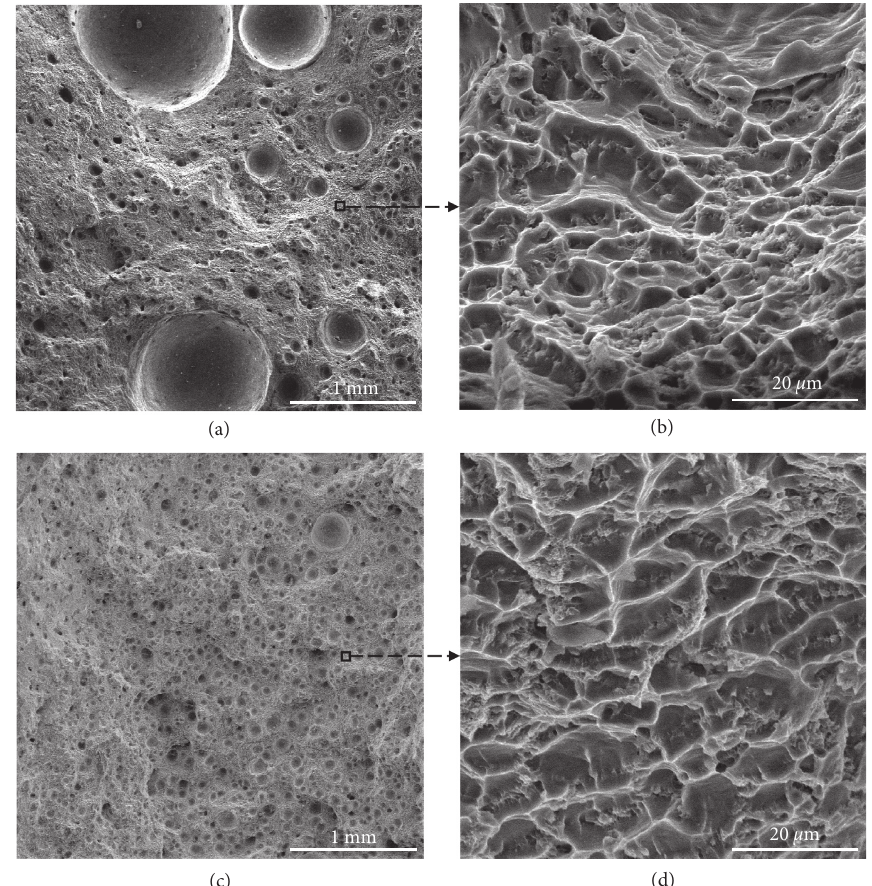
Figure 15: Tensile fracture surface and SEM image of the deposition wall in the deposition velocity direction: (a), (b) without the path constraint; (c), (d) with the copper plates constrained